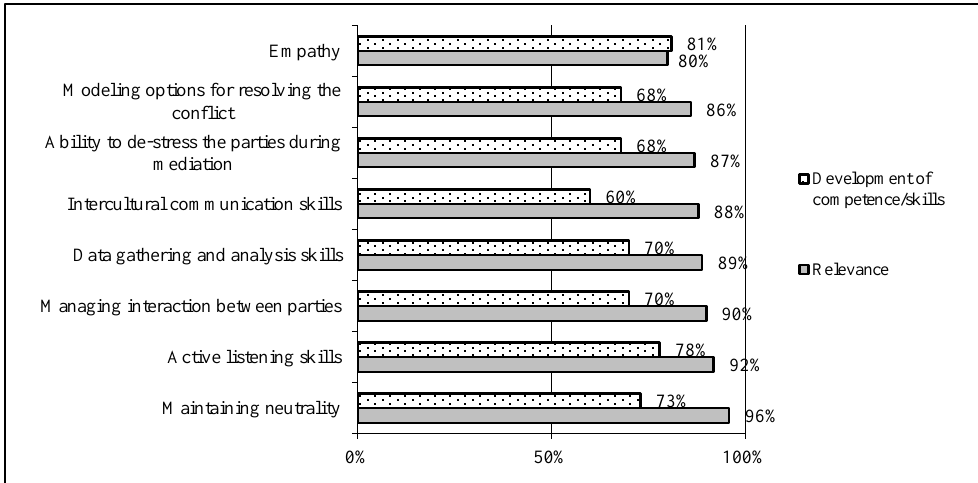
Figure 2. Expert Survey: Importance of mediator’s individual competencies and self-assessment of their